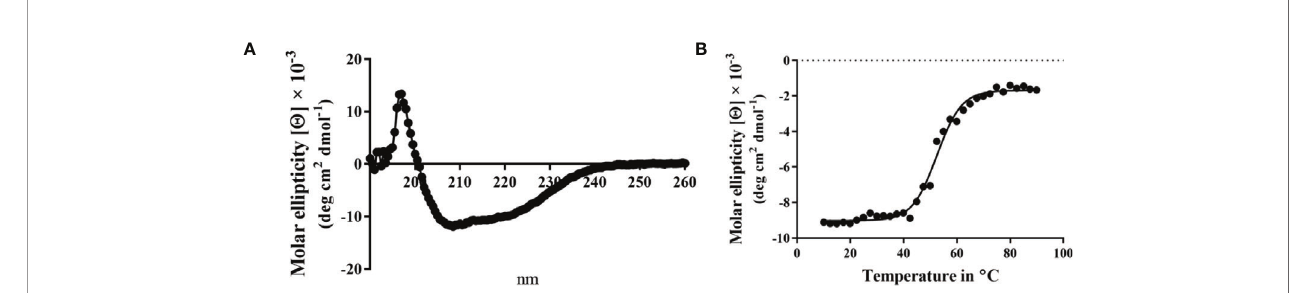
FIGURE 4 | CD spectrum of the wild-type Spa33-MxiK complex. (A) The secondary structure of the Spa33-MxiK complex shows a greater a -helical character than the Spa33 heterotrimer alone. (B) To determine thermal stability, molar ellipticity at 222 nm was monitored as a function of temperature. Based on the large thermal transition observed, the complex had a Tm of approximately 52.46°C. This Tm is lower than that of wild-type Spa33 (62°C) and higher than that of the chimera MxiK-T4L-C (39°C), suggesting that the Spa33 interaction enhances MxiK solubility and thermal stability. R 2 =